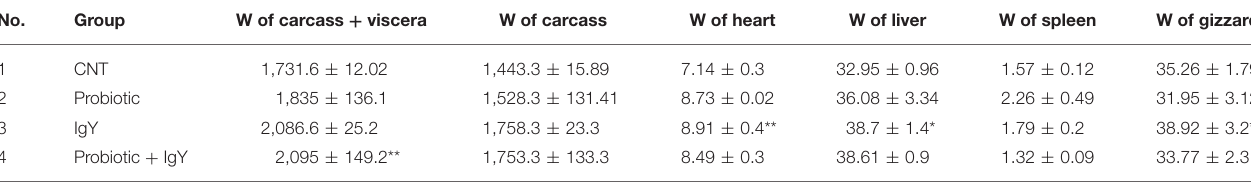
TABLE 3 | The statistics of carcass and internal organ weights (g) of broilers supplemented with variant feed additives. No.